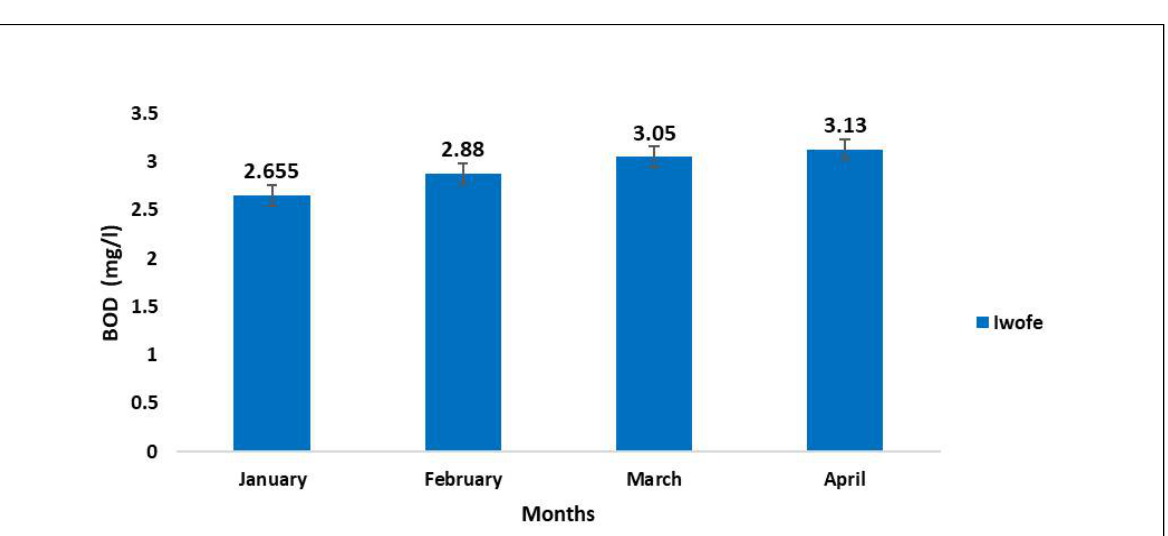
Figure 3: Biological Oxygen Demand level of Iwofe